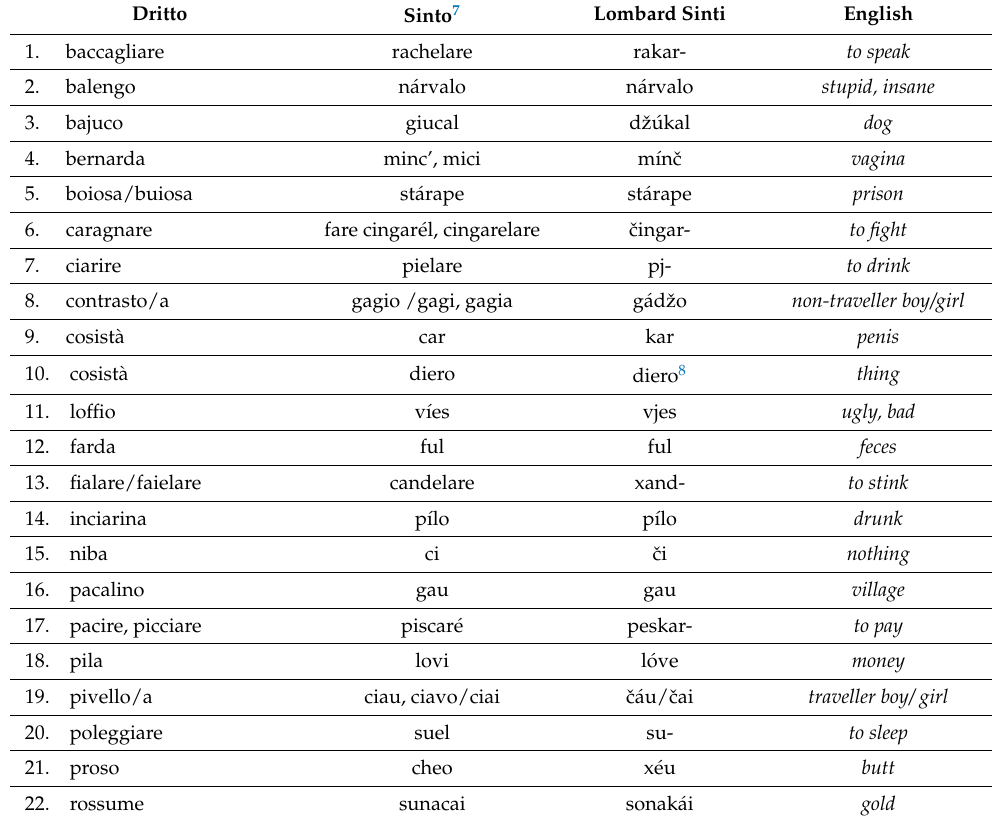
Table 1. Lexical dual system in Neodritto.